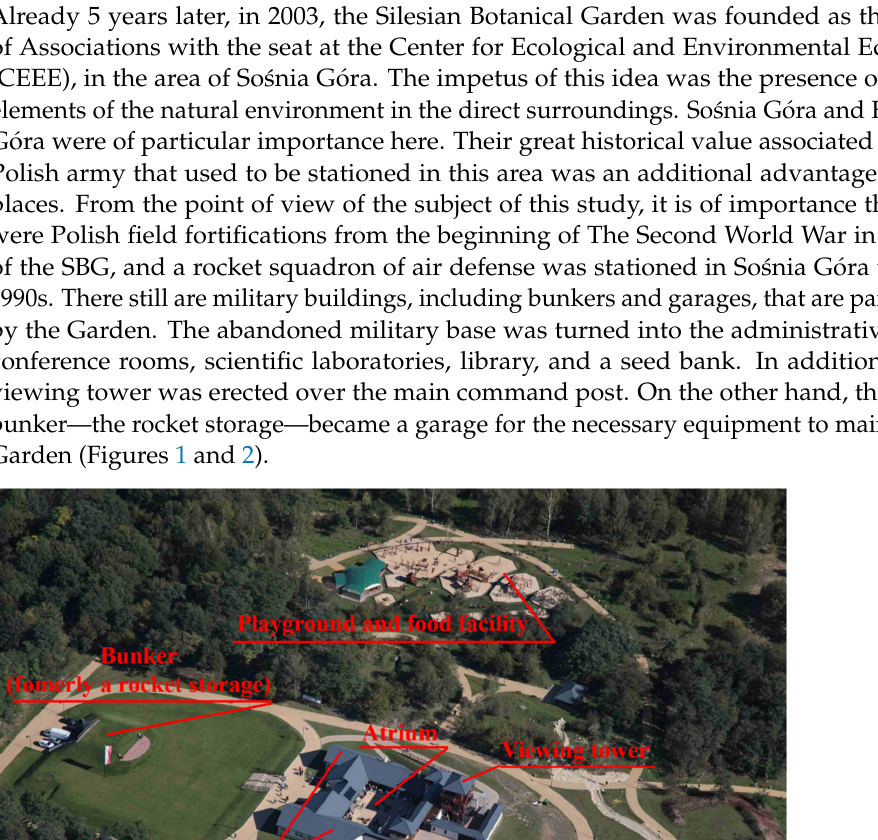
Figure 2. The Silesian Botanical Garden’s seat at the building of Centre for Ecological and Environ- mental Education (CEEE), on the So ś nia Góra in Miko ł ów, Poland (source: phot. of Janusz Moczulski, 2013); available thanks to 2013 Pawe ł Kojs’ permission).